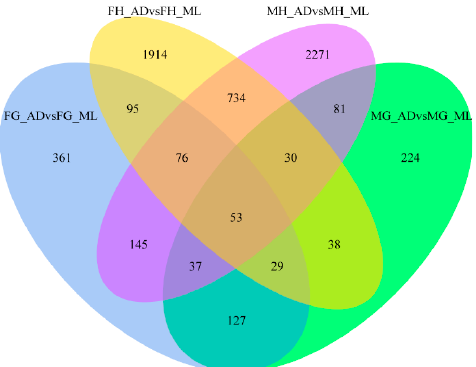
Figure 4. Venn diagram of DEGs. Venn diagram illustrating unique and common DEGs in FG_ADvsFG_ML, MG_ADvsMG_ML, FH_ADvsFH_ML and MH_ADvsMH_ML based on statistical significance cut-off p -adj <0.05.